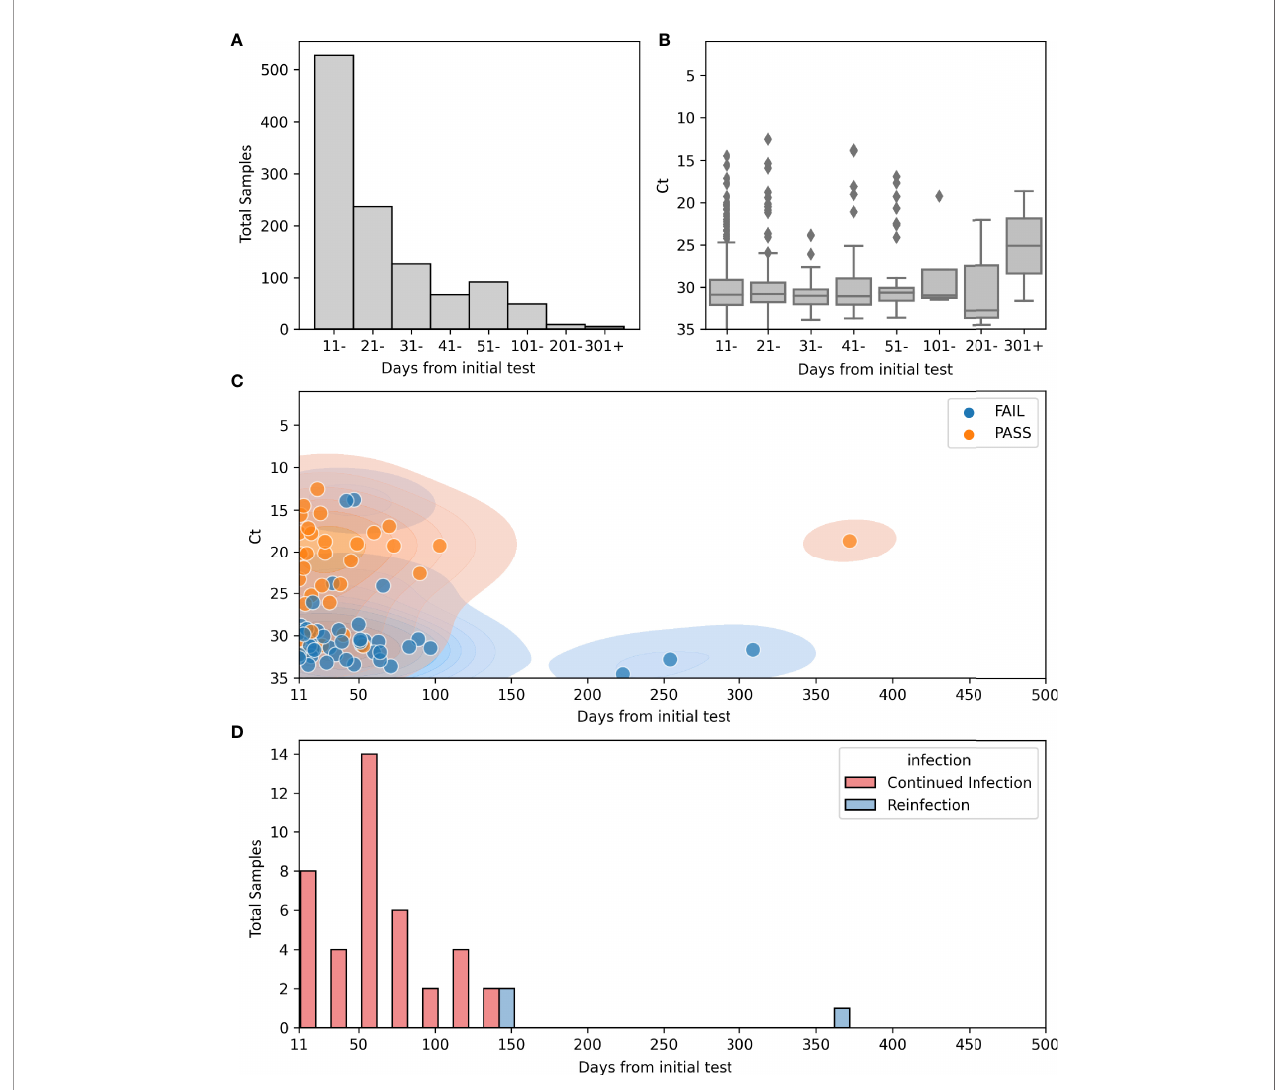
FIGURE 2 | Repeat positives from March 11 th 2020 to September 23 rd 2021. (A) Count plot of total numbers of repeat positives >10 days from the initial positive and the relation to the time after the fi rst positive (N = 1115): 528 (11-20), 237 (21-30), 127 (31-40), 67 (41-50), 92 (51-100), 49 (101- 200), 9 (201-300), 6 (301- 400). (B) Boxplot for Ct values in repeat positive samples and the relation to the time after the fi rst positive (N = 589): 306 (11-20), 140 (21 -30), 60 (31- 40), 34 (41- 50), 40 (51-100), 4 (101-200), 3 (201- 300), 2 (301-400). (C) Scatterplot of sequenced repeat samples >10 days from initial positive overlying kernel density estimate (KDE plot) of the same information. Hue indicates quality of sequences. N=222 Total, 155 failed quality metrics, 67 High quality genomes. (D) Histogram of days from initial positive sample in continued infection (Red, N = 40) or reinfection (Blue, N =